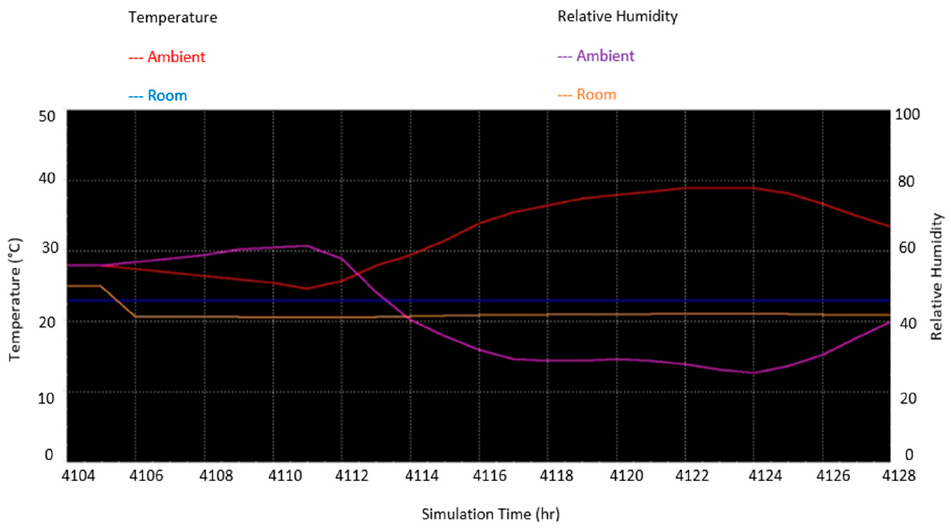
Figure 15. 1st June simulation run for option B.